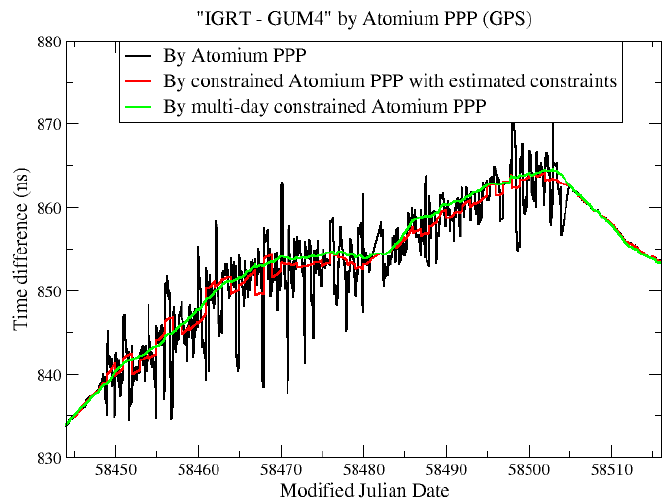
Figure 13. “IGRT—GUM4” from PPP and constrained PPP.